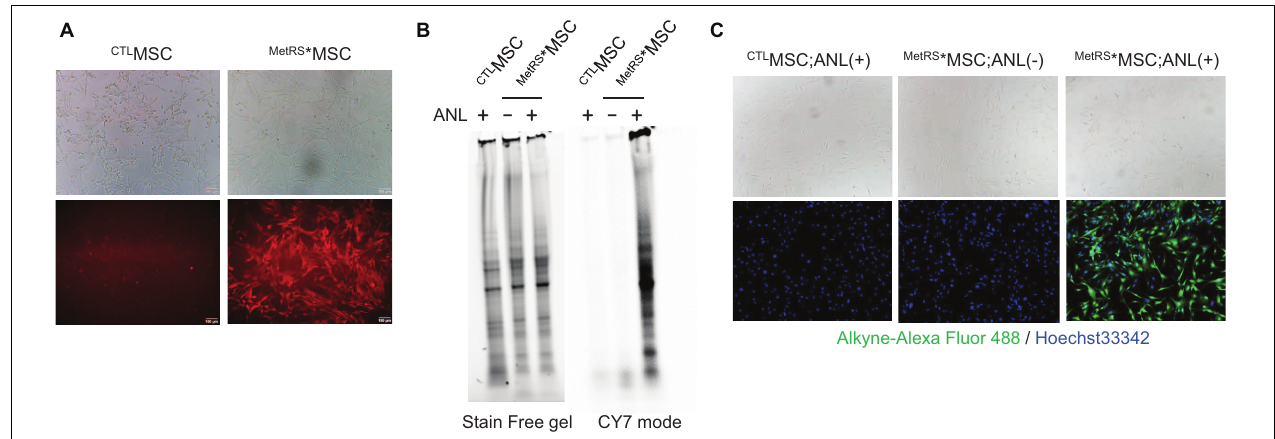
FIGURE 1 | Proteins from ANL-treated MetRS ∗ MSCs can be detected via alkyne-Cy7 click-staining. MSCs were transfected with Lenti-CAG-MetRS L274G –mCherry ( MetRS ∗ MSCs) or a control lentiviral vector ( CTL MSCs). (A) Morphology of the transfected cells was evaluated via phase contrast microscopy (top), and transfection of MetRS ∗ MSCs was confirmed by visualizing mCherry fluorescence (bottom). (B,C) MetRS ∗ MSCs and CTL MSCs were incubated with ANL (+) or vehicle (–) for 24 h. (B) MSCs were lysed; then, proteins were separated on an SDS-PAGE gel, click-stained with alkyne-Cy7, and imaged in stain-free and Cy7 mode (BONCAT). (C) MSCs were permeabilized, click-stained with alkyne-Alexa Fluor 488, and viewed via phase contrast microscopy (top) or under fluorescence (bottom) (FUNCAT); nuclei were counterstained with Hoechst, and ANL-labeled proteins were identified via alkyne-Alexa Fluor 488 fluorescence.